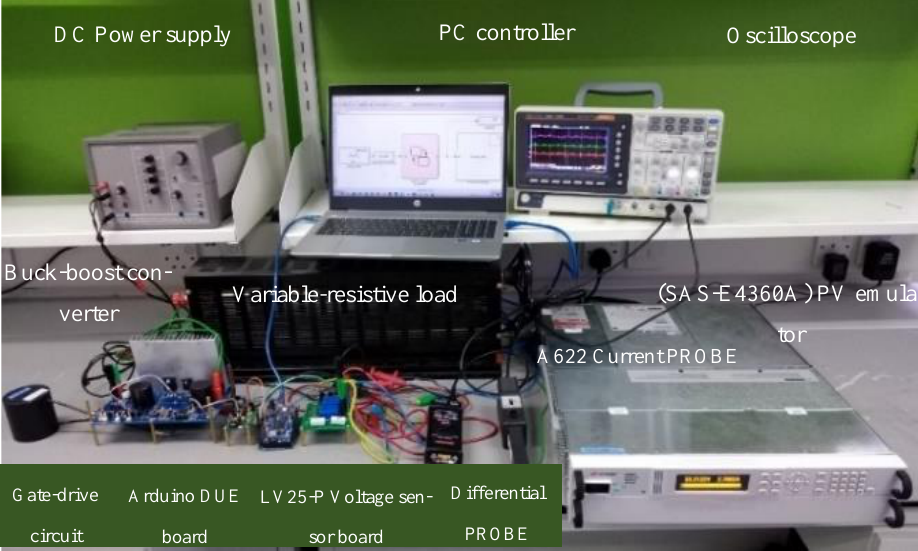
Figure 17. The hardware set-up used for the experimental verification.